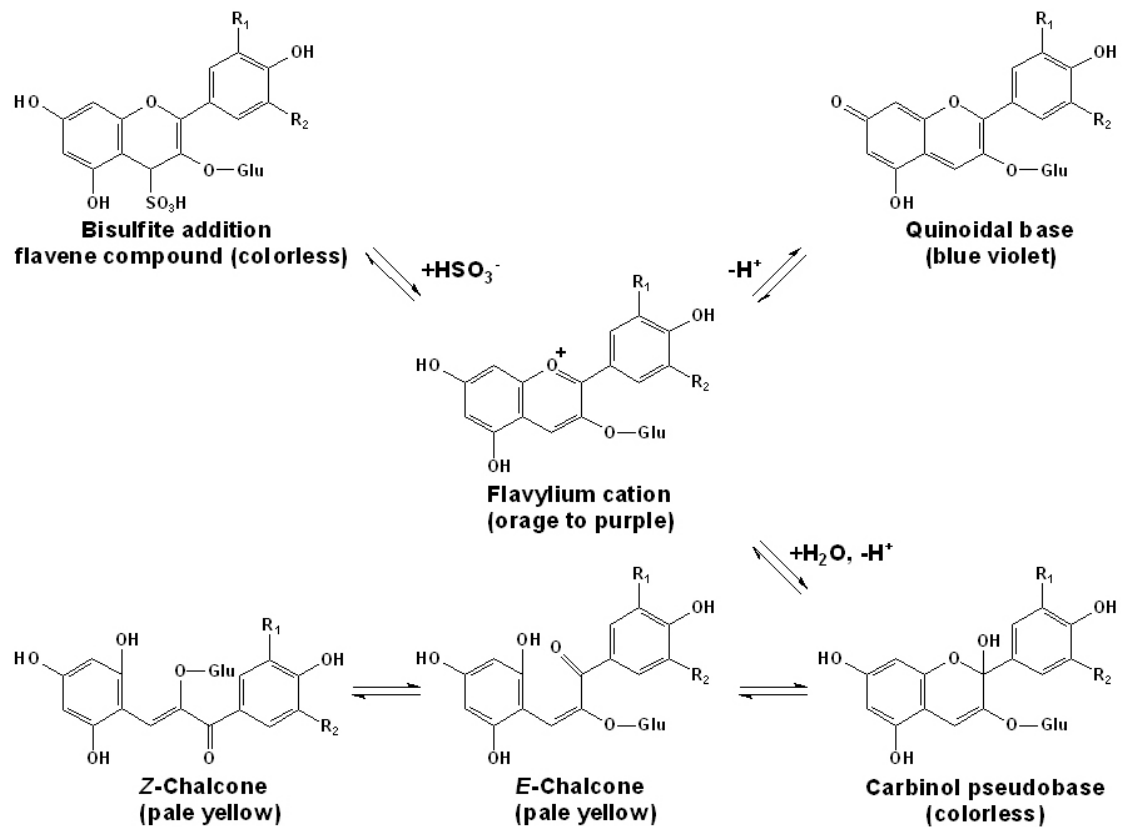
and R are listed in Figure 1 2